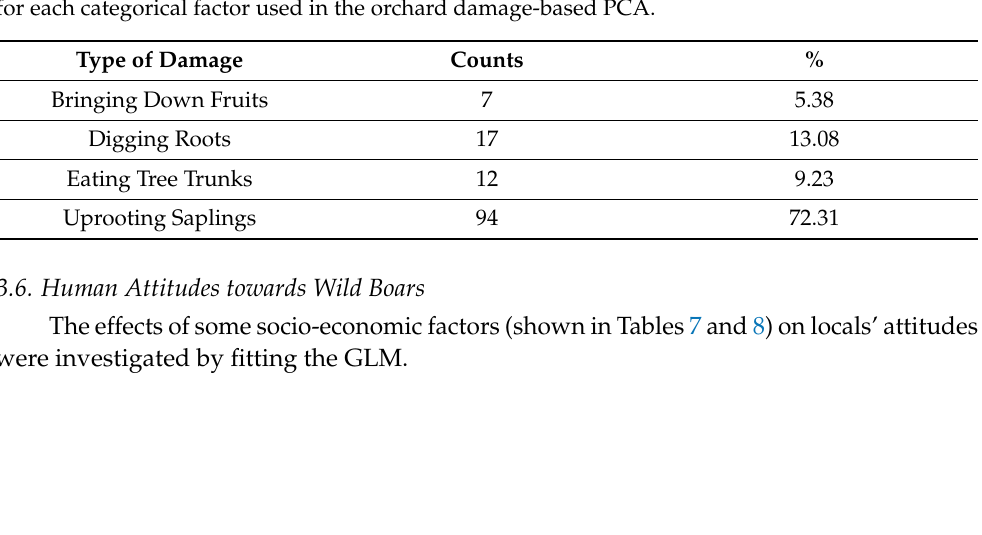
Table 5. Orchard damage type ( n = 130) by wild boars used in the orchard damage-based PCA. The values shown include the number of crop damages for each level (counts) and the percentages (%) for each categorical factor used in the orchard damage-based PCA.